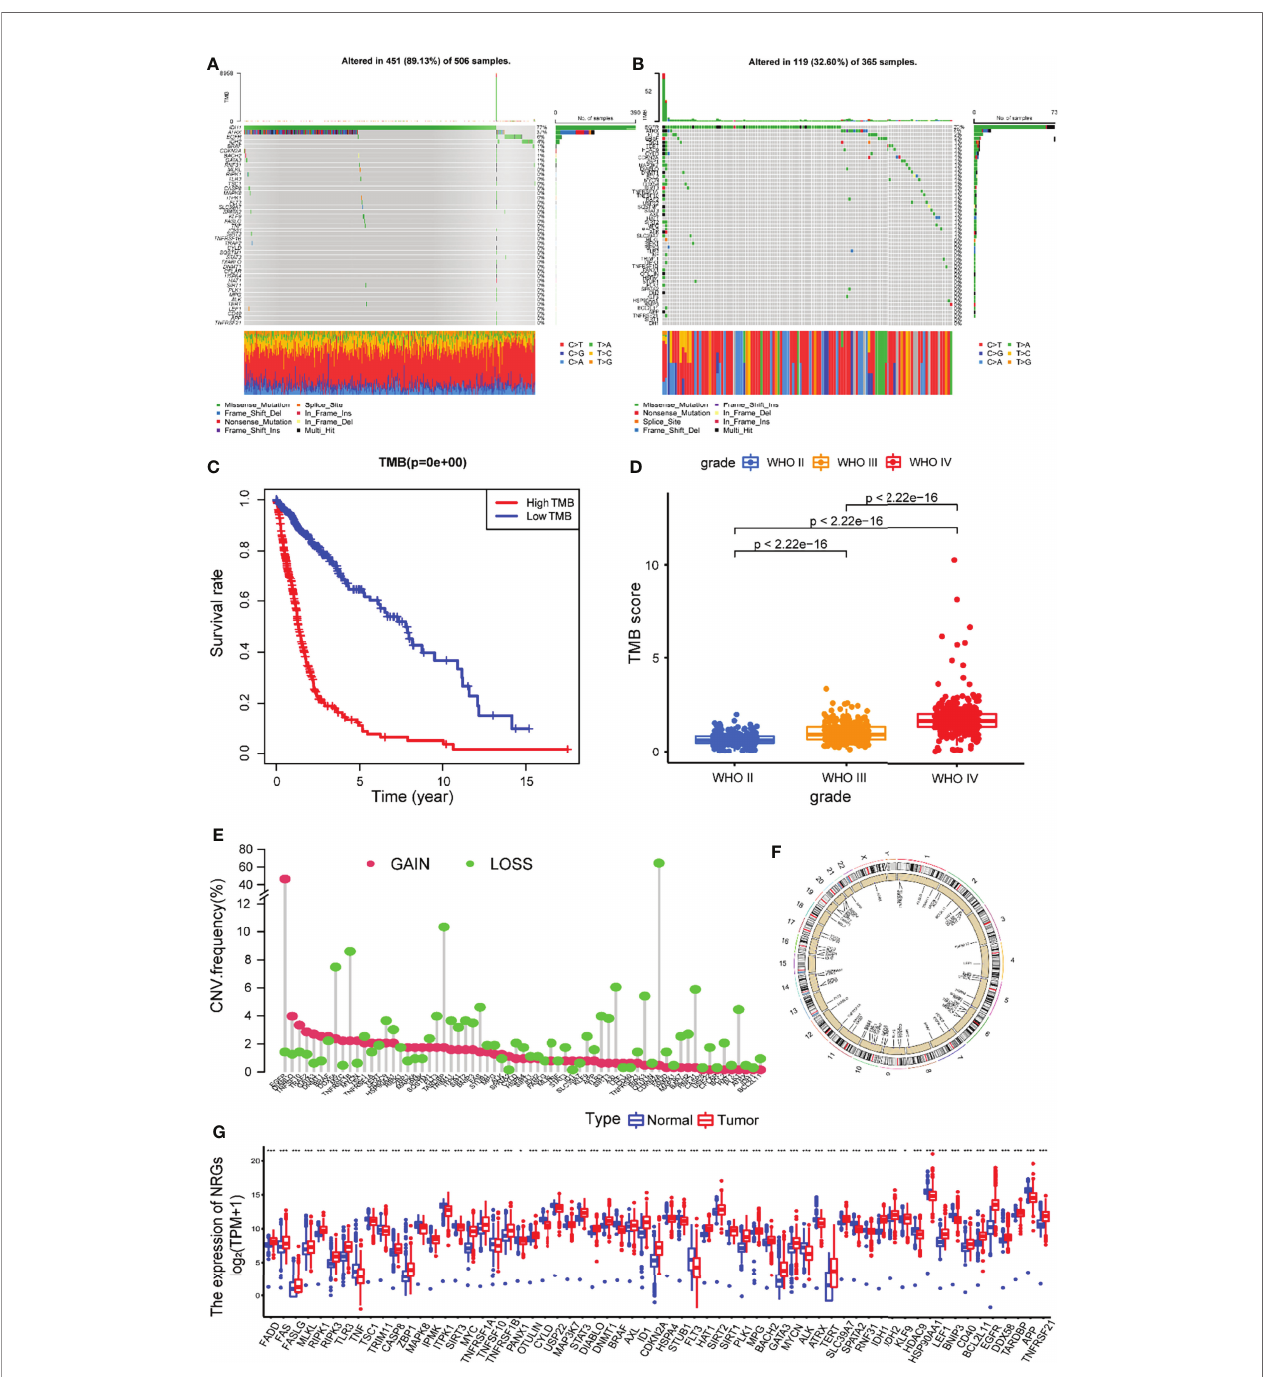
FIGURE 2 | The landscape of genetic and transcriptional variation of NRG in glioma. Mutation frequencies of 67 NRGs in 506 patients with LGG (A) and 365 GBM patients without IDH1 mutation (B) from the TCGA dataset. (C) Kaplan-Meier survival analysis of the high TMB and low TMB groups. (D) Comparison of TMB score in gliomas of different grades. (E) The CNV variation frequencies of 67 NRGs in the patients with LGG or GBM from the TCGA dataset. (F) Locations of CNV alterations of 67 NRGs on 23 chromosomes. (G) The differential expression of 67 NRGs between gliomas and normal brain tissue. NRGs, necroptosis-related genes; LGG, low grade gliomas; GBM, glioblastoma; TCGA, The Cancer Genome Atlas; CNV, copy number variant; ***P<0.001, **P<0.01,